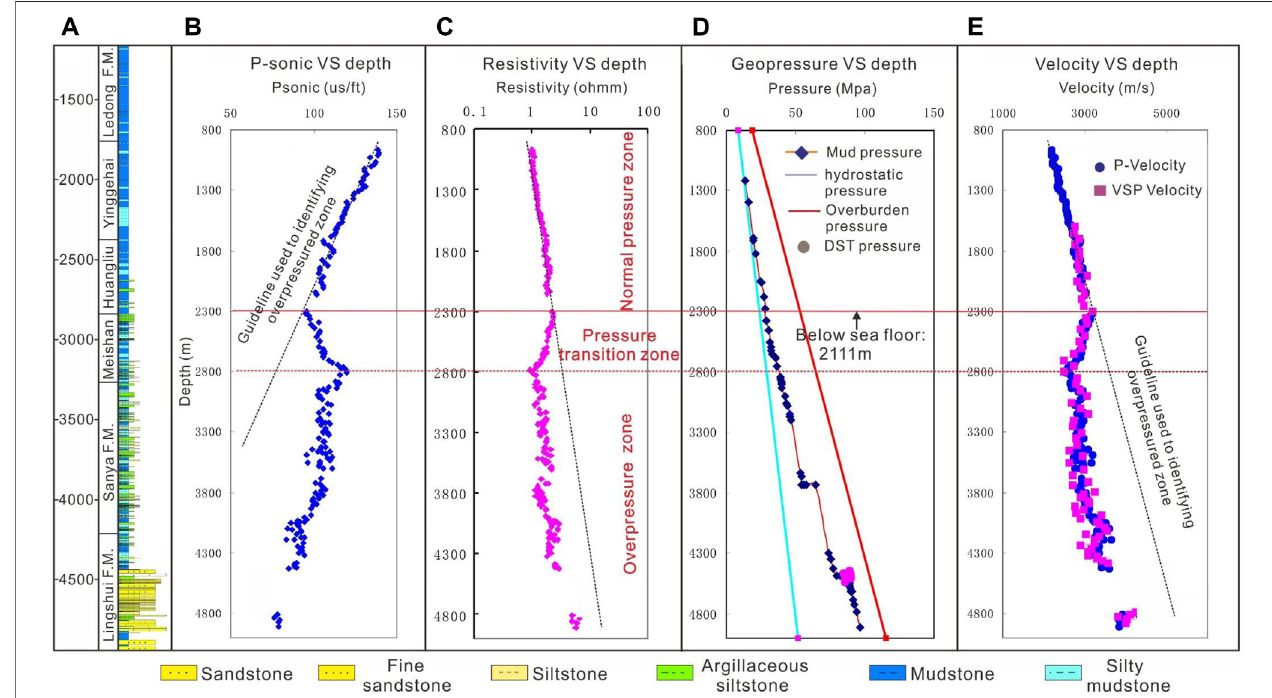
FIGURE 4 | (A) Lithologic pro fi le of Well A (B) Pseudo log of sonic P-wave transit times for mudstone. The plot shows the deviation of transit time from the compaction trend below about 2,300 m. (C) Plot of log-derived resistivity values for mudstone showing deviation from the compaction trend below about 2,300 m. (D) Plot of calculated mud pressures and drill stem test pressures showing a corresponding positive deviation from hydrostatic pressure (overpressure) below about 2,700 m. (E) Seismic velocity (VSP velocity) and P-wave sonic velocity plots that show similar deviation from the compaction trend in the overpressure section, which supports the premise that seismic velocity can be used topredict overpressure. Azone ofnormal pressure is evident above 2,300 m, an apparent transition zone occursfrom around 2,300 – 2,800 m, and thedecrease invelocity below2,800 m corresponds tothezone ofoverpressure.Thewater depthinWellAis189 m. The well location is shown in Figure 1